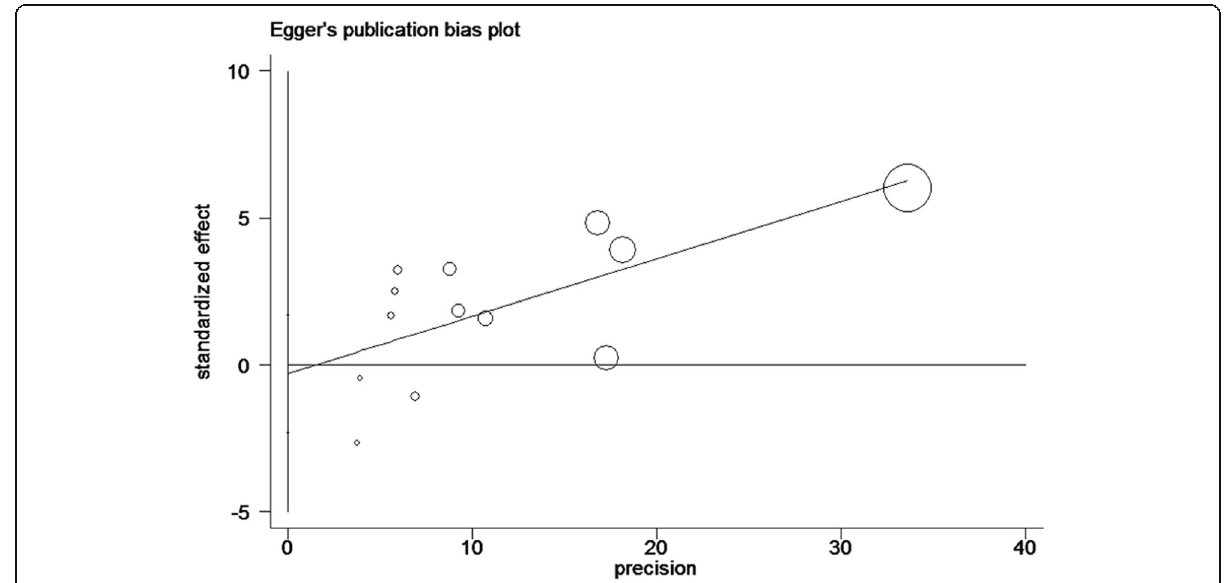
Fig. 7 Egger ’ s test for rs610604 in TNFAIP3 gene and risk of psoriasis